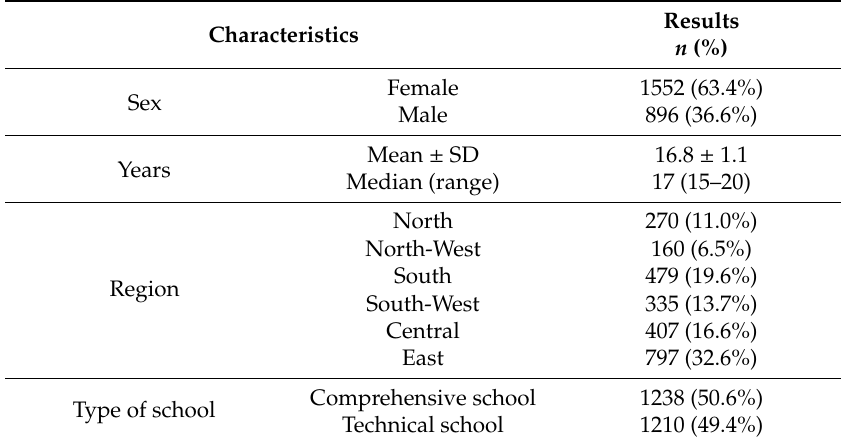
Table 1. Descriptive characteristics of the study sample of Polish adolescents within the PLACE-19 Study ( n =